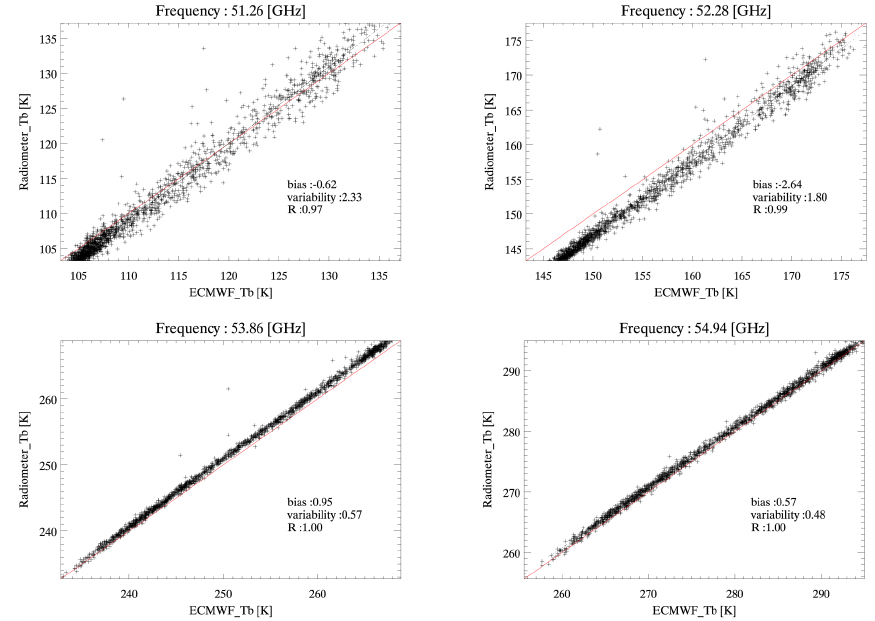
Figure 5. Scatter diagram of T E